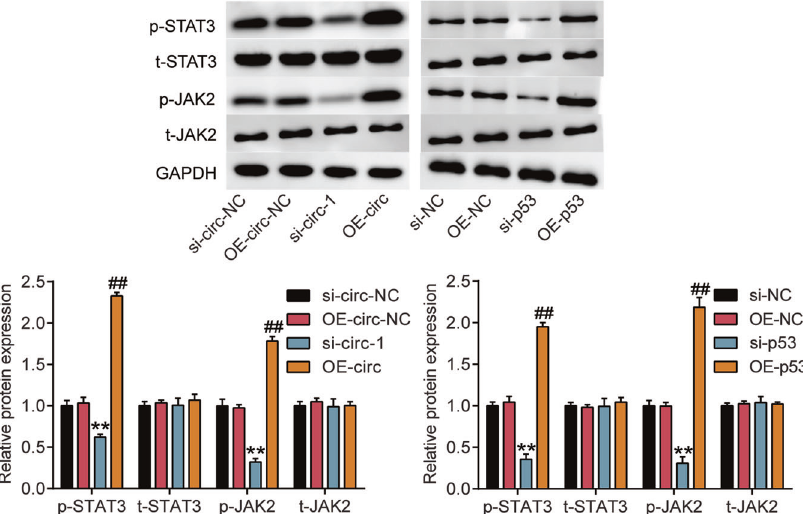
Fig. 6 Circ-DMNT1/p53 activates the JAK/STAT3 signaling pathway in trophoblast cells. The expression of JAK2 and STAT3 protein were upregulated by the OE-circ or OE-p53, while were downregulated by the si-circ-1 or si-p53 in HTR-8/SVneo cells. ** P < 0.001 compared with si- circ-NC or si-NC. ## P < 0.001 compared with OE-circ-NC or OE-NC. N = 3, repetition =